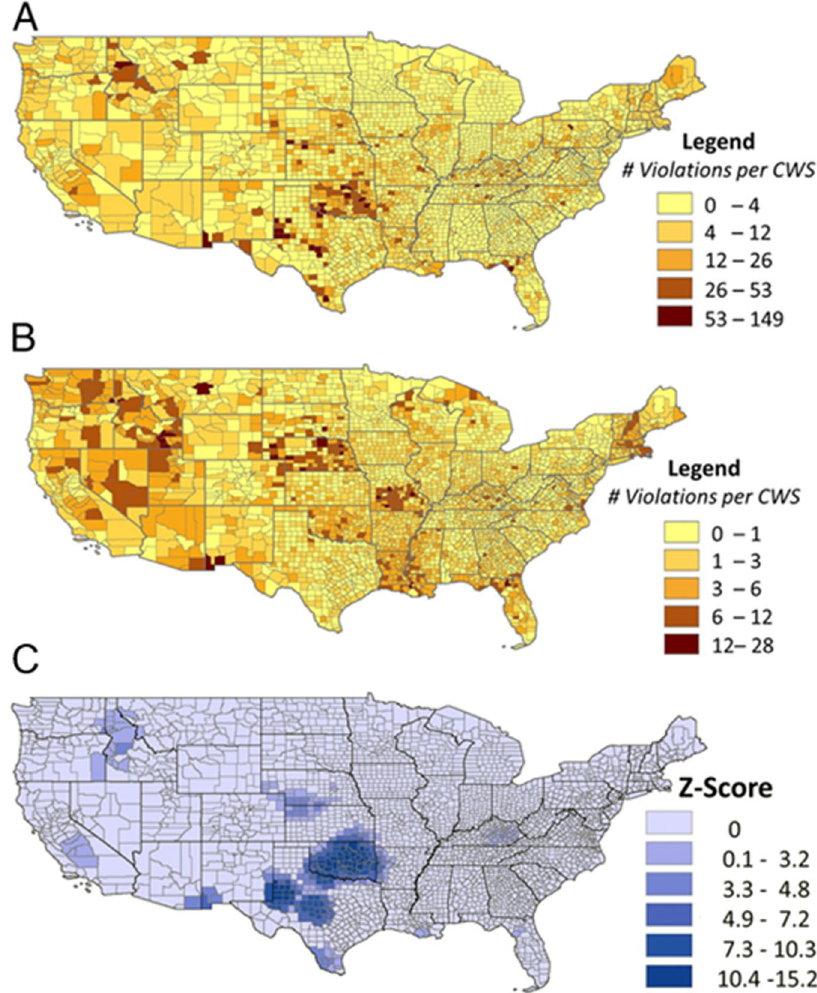
Fig. 2 Distribution of the total number of violations per CWS. A Total violations. B Total coliform violations. C Spatial clusters (hot spots) of health-based violations, 1982 – 2015. Violations also vary considerably across geographic locations. Some of the counties with the highest prevalence of violations are rural, located in Texas, Oklahoma, and Idaho (reprinted with permission from 33 , Copyright © PNAS,